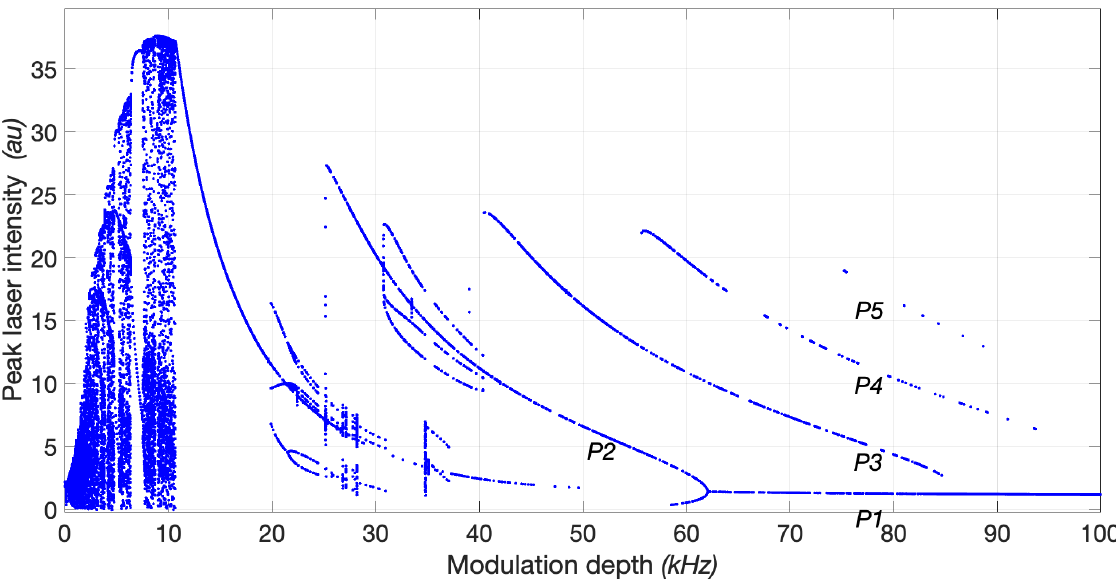
Figure 2. Bifurcation diagrams of peak laser intensity P with driving frequency f 0 as a control parameter for m 0 = 1. P 1, P 3, P 4, and P 5 are branches of the corresponding coexisting attractors found by taking different initial